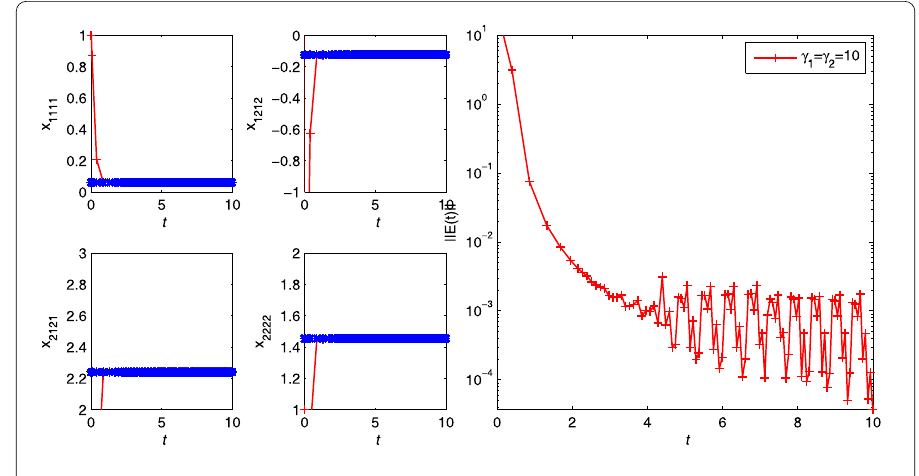
Figure 6 Convergence of NTCTZNN3 for the solution of problem